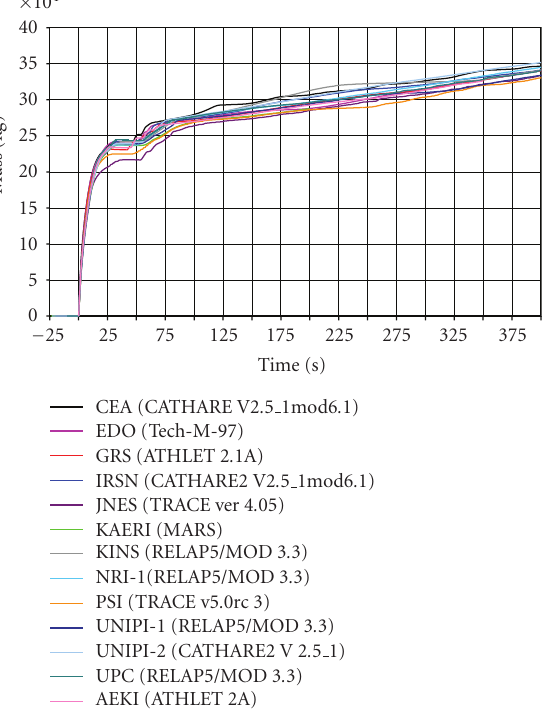
Figure 7: Time trends of integral break mass flow.